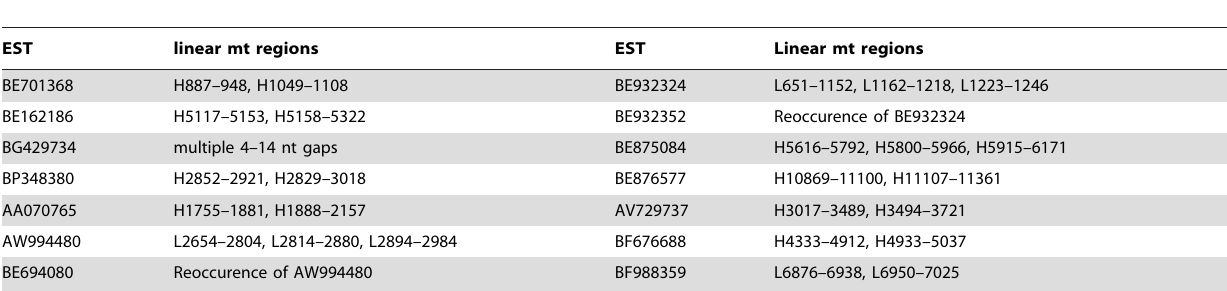
EST linear mt regions EST Linear mt